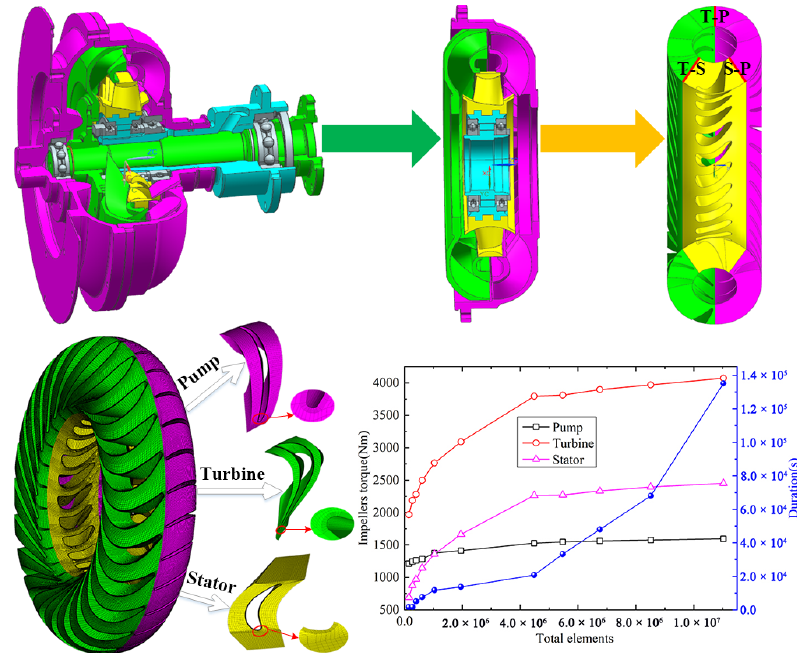
Figure 2. HTC CFD model and grid independence study. Table 1. Structural parameters of HTC.